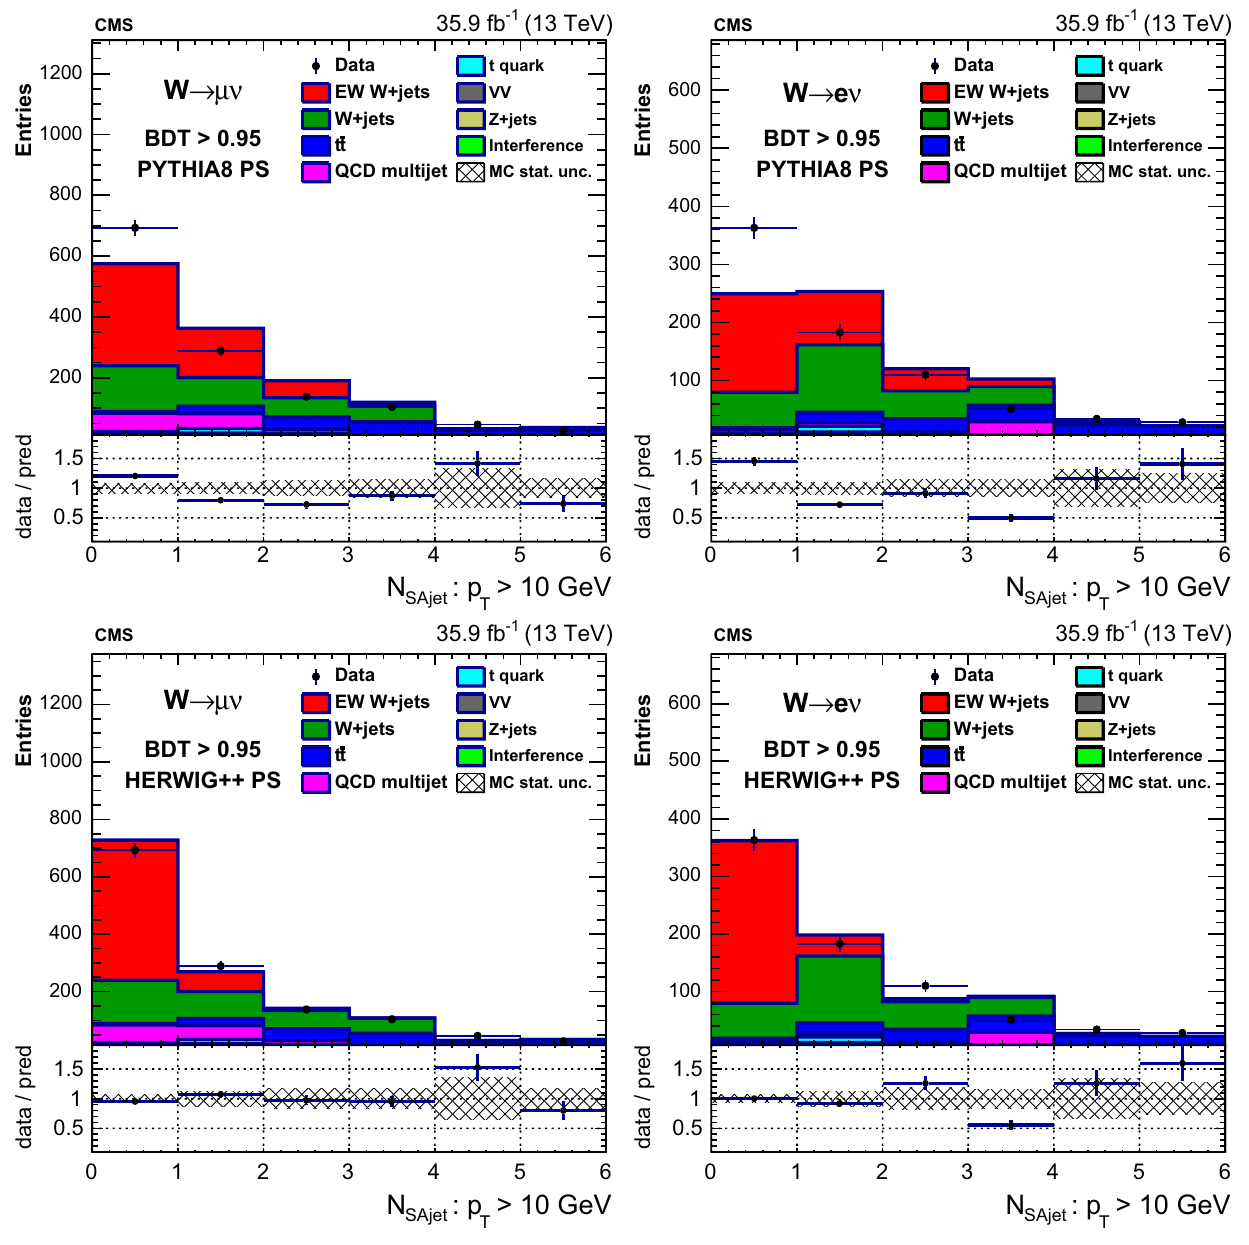
Fig. 20 Number of soft activity jets with p T > 10GeV in the rapidity gap for BDT > 0 . 95 in the muon (left) and electron (right) channels including signal with pythia parton showering (upper) and herwig++ parton showering (lower). In all plots the last bin contains overflow